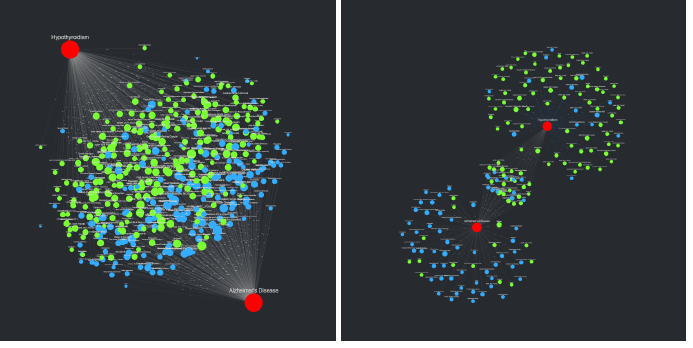
Figure 11. The SemNet sample data, both unfiltered ( a ) and filtered ( b ), based on criteria described in Section